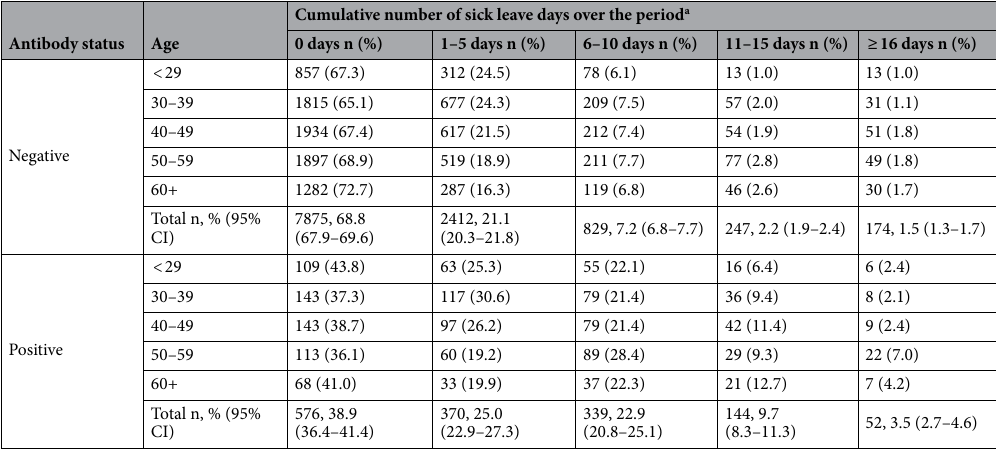
Table 3. Duration of sick leave in days, by SARS-CoV-2 serology test result and age. a Sick leave days in the 6 weeks prior to